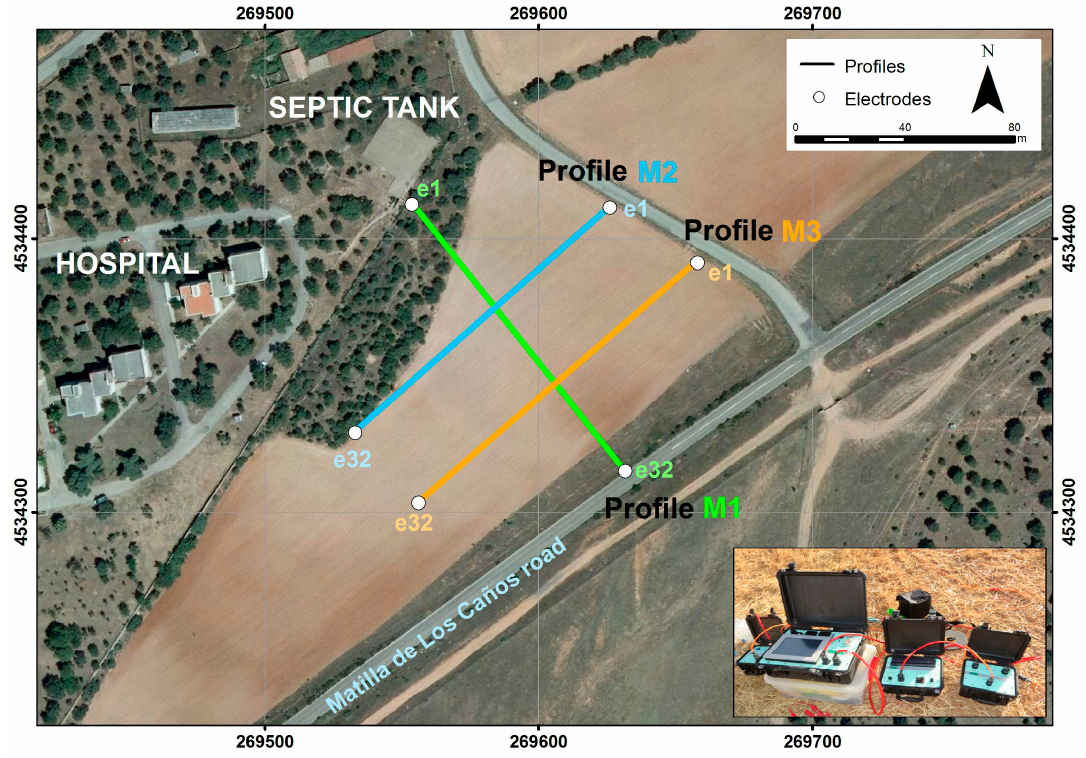
Figure 5. A. Location of acquisition of three profiles M1, M2 and M3. The inset shows the PASI 16SG24 ‐ N resistivimeter, the energizer and the two link boxes.